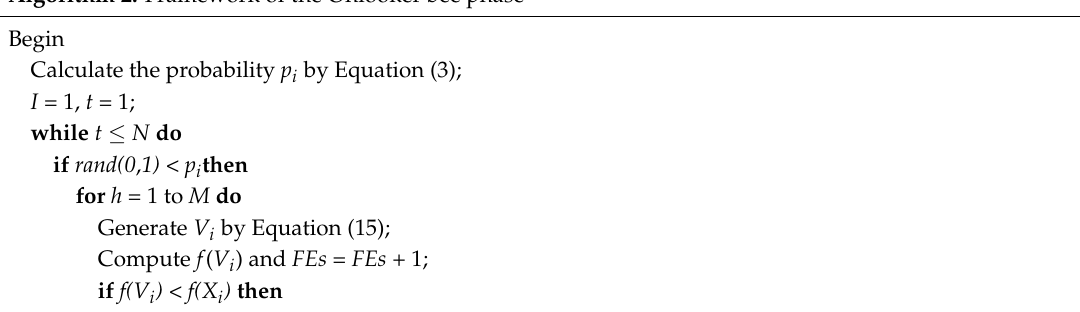
Algorithm 2: Framework of the Onlooker bee